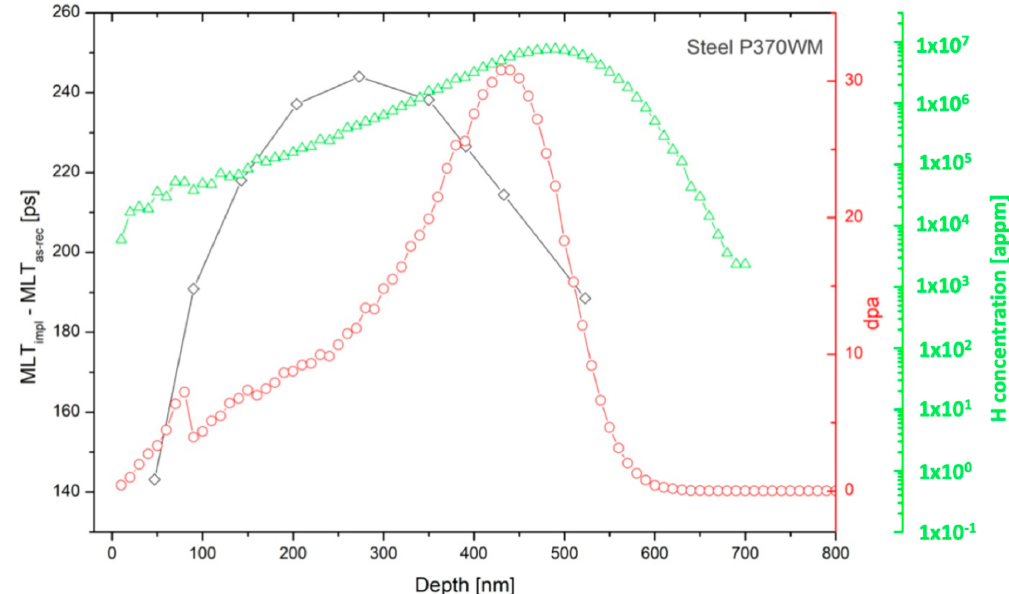
Figure 5. Comparison difference of positron mean lifetimes values before and after H + implantation of specimen P370 WM to dpa and H concentration profiles derived from SRIM code.